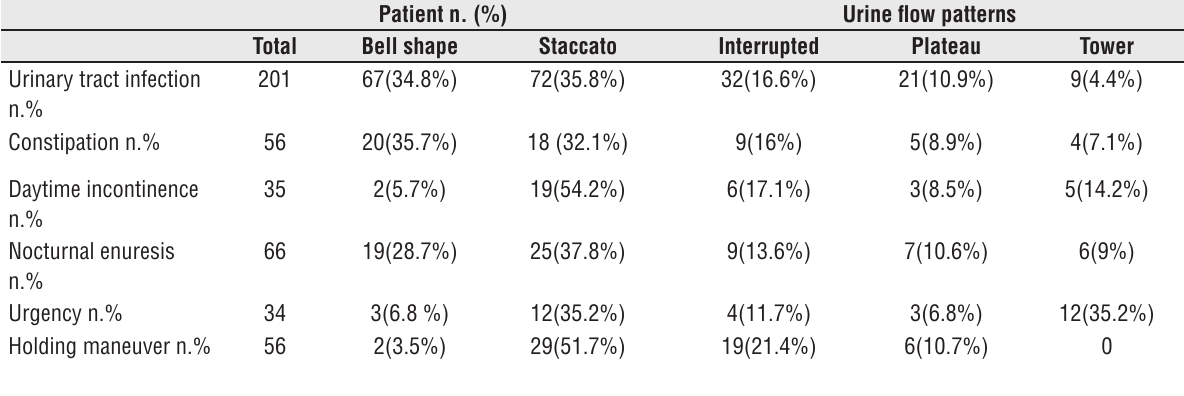
Table 3 - Lower urinary tract symptoms in different flow groups of